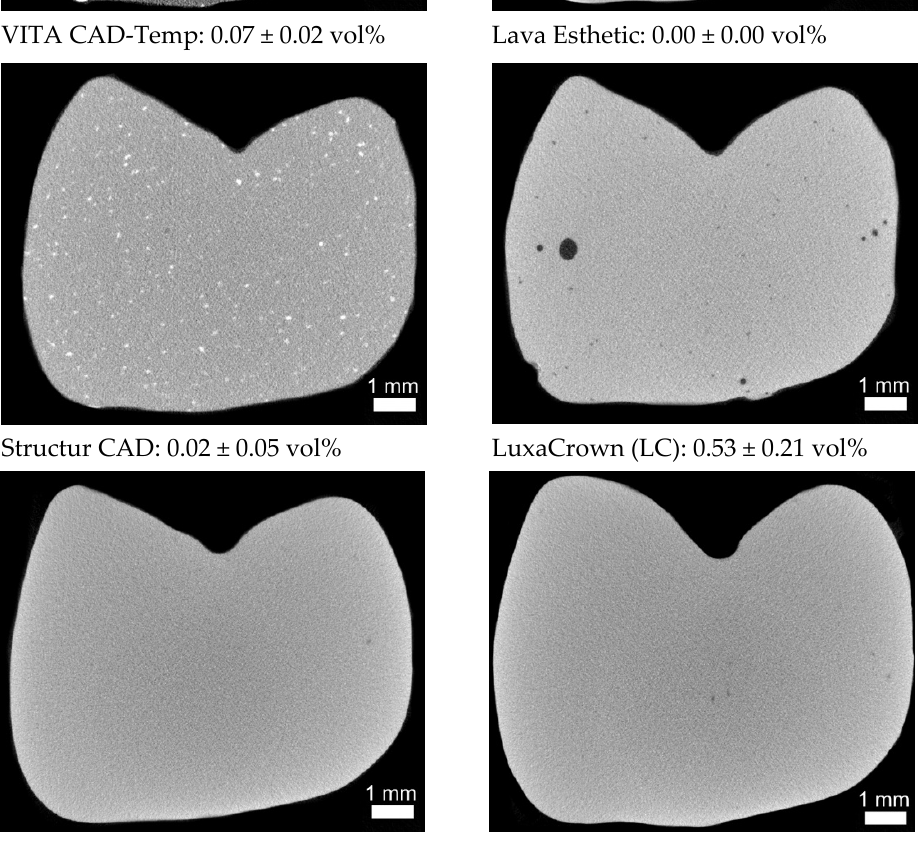
Figure 5. µ XCT sectional images from the centre of the three-unit FDPs, each with the total porosity (measured on a region of interest (ROI) 6 mm × 4 mm × 4.2 mm from the centre of the restora- tion).